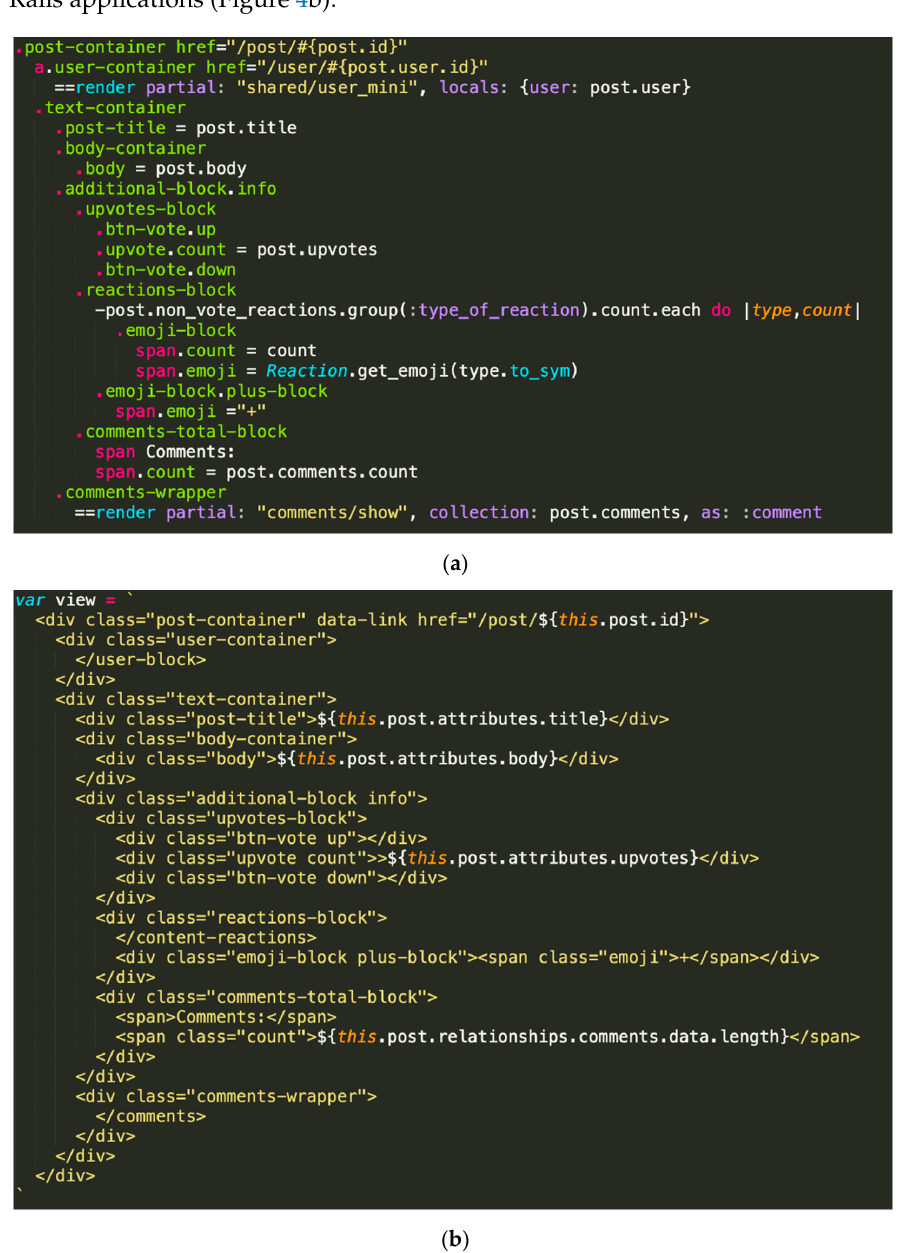
Figure 4. ( a ): Templating mechanism for a Post View implemented with the Slim templating language. ( b ): Templating mechanism for a Post View implemented with JavaScript.